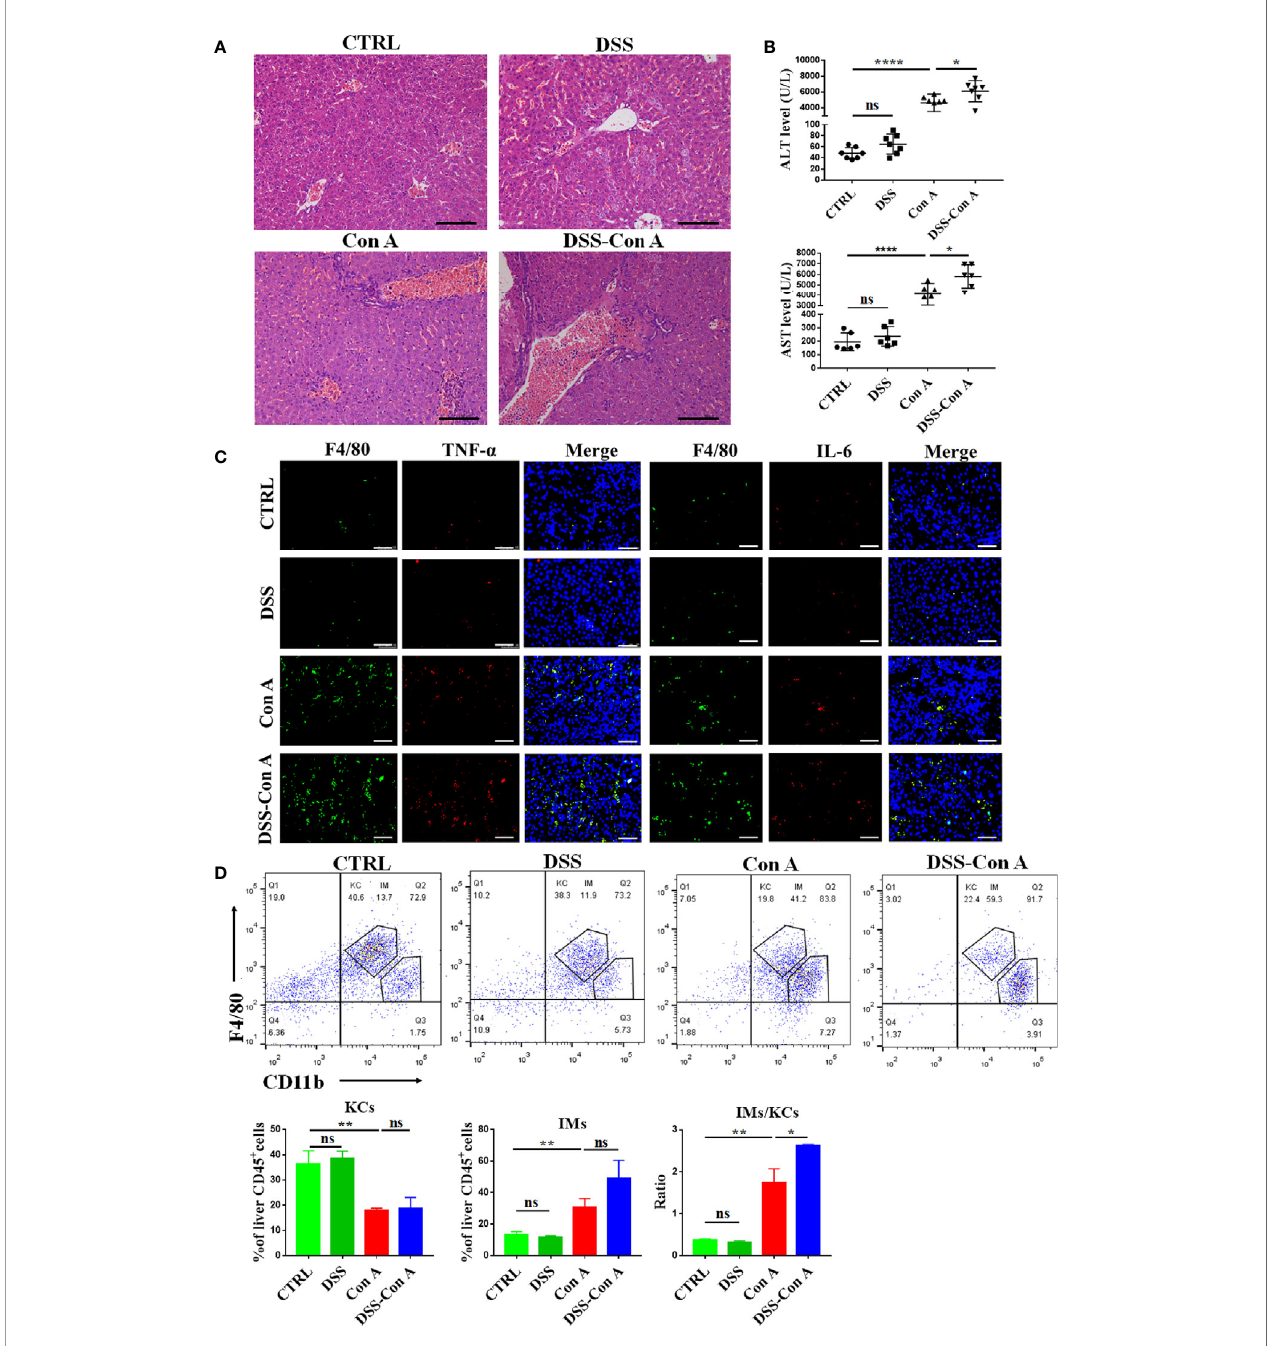
FIGURE 4 | Breakage of the intestinal barrier aggravated liver injury and in fi ltration of liver macrophages. (A) HE staining of liver tissues in four groups. (B) The plasma concentrations of ALT and AST in four groups. (C) Double-immuno fl uorescence staining for F4/80 and TNF- a , F4/80 and IL-6 of liver tissues in four groups. (D) Representative fl ow cytometry plots and percentage of CD45 + F4/80 hi CD11b lo Kupffer cells and CD45 + F4/80 lo CD11b hi in fi ltrating macrophages in mononuclear cells from liver of the four groups. (n=6). Scale bars: 50 m m. The data were presented as means ± SD (Student ’ s t-test, *p < 0.05, **p < 0.01, ****p < 0.0001, ns: p <